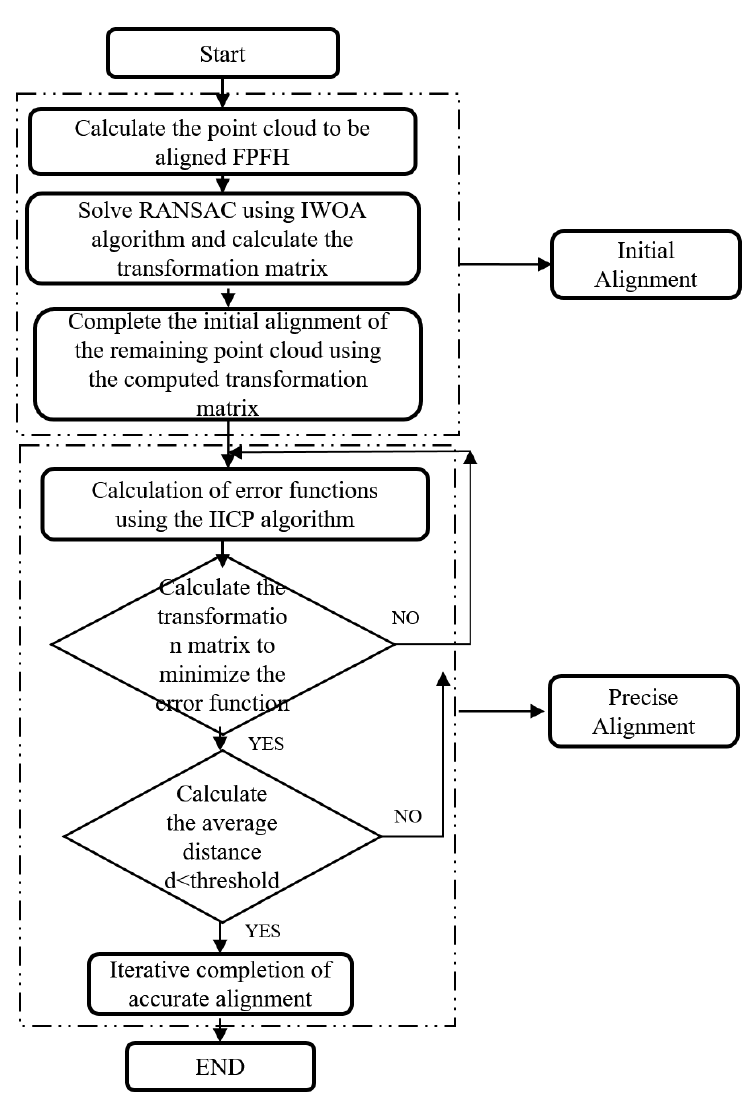
Figure 3. Flowchart for the initial registration of RANSAC by IWOA+ accurate registration of the improved ICP.